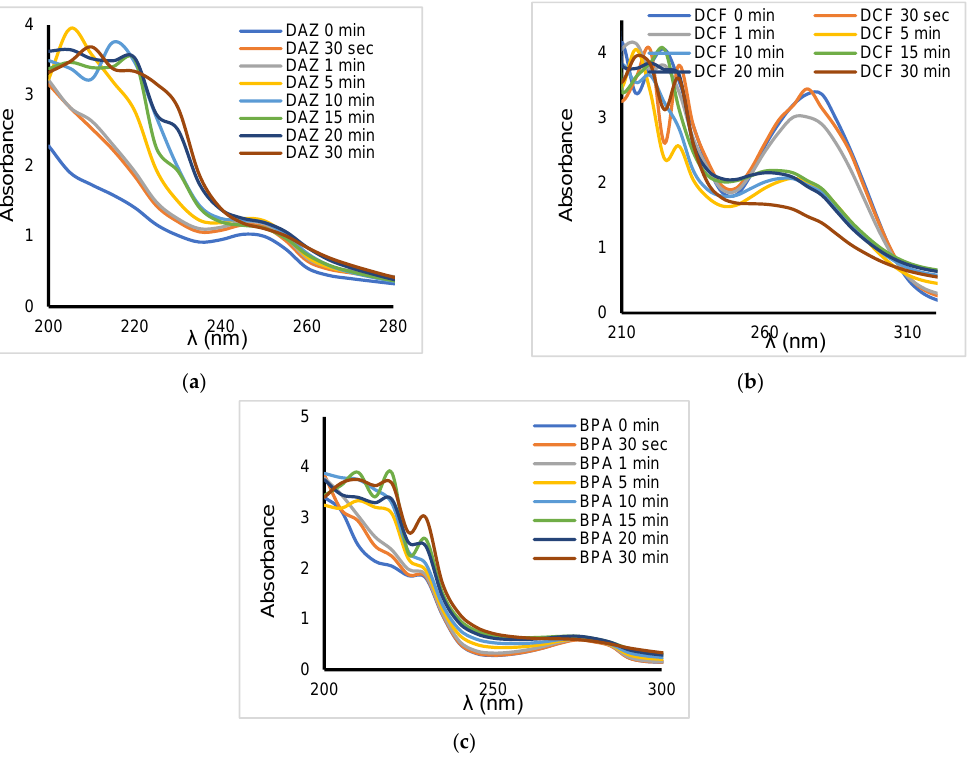
Figure 4. Evolution of UV-Vis spectra of the aqueous solutions of DAZ (a), DCF (b) and BPA (c) during non-catalytic ozonation at room temperature. V = 30 mL, Quartz cell length = 1 cm; Ozone throughput = 600 mg h −1 ; Initial concentration of organic substrate = 30 mg L −1 .